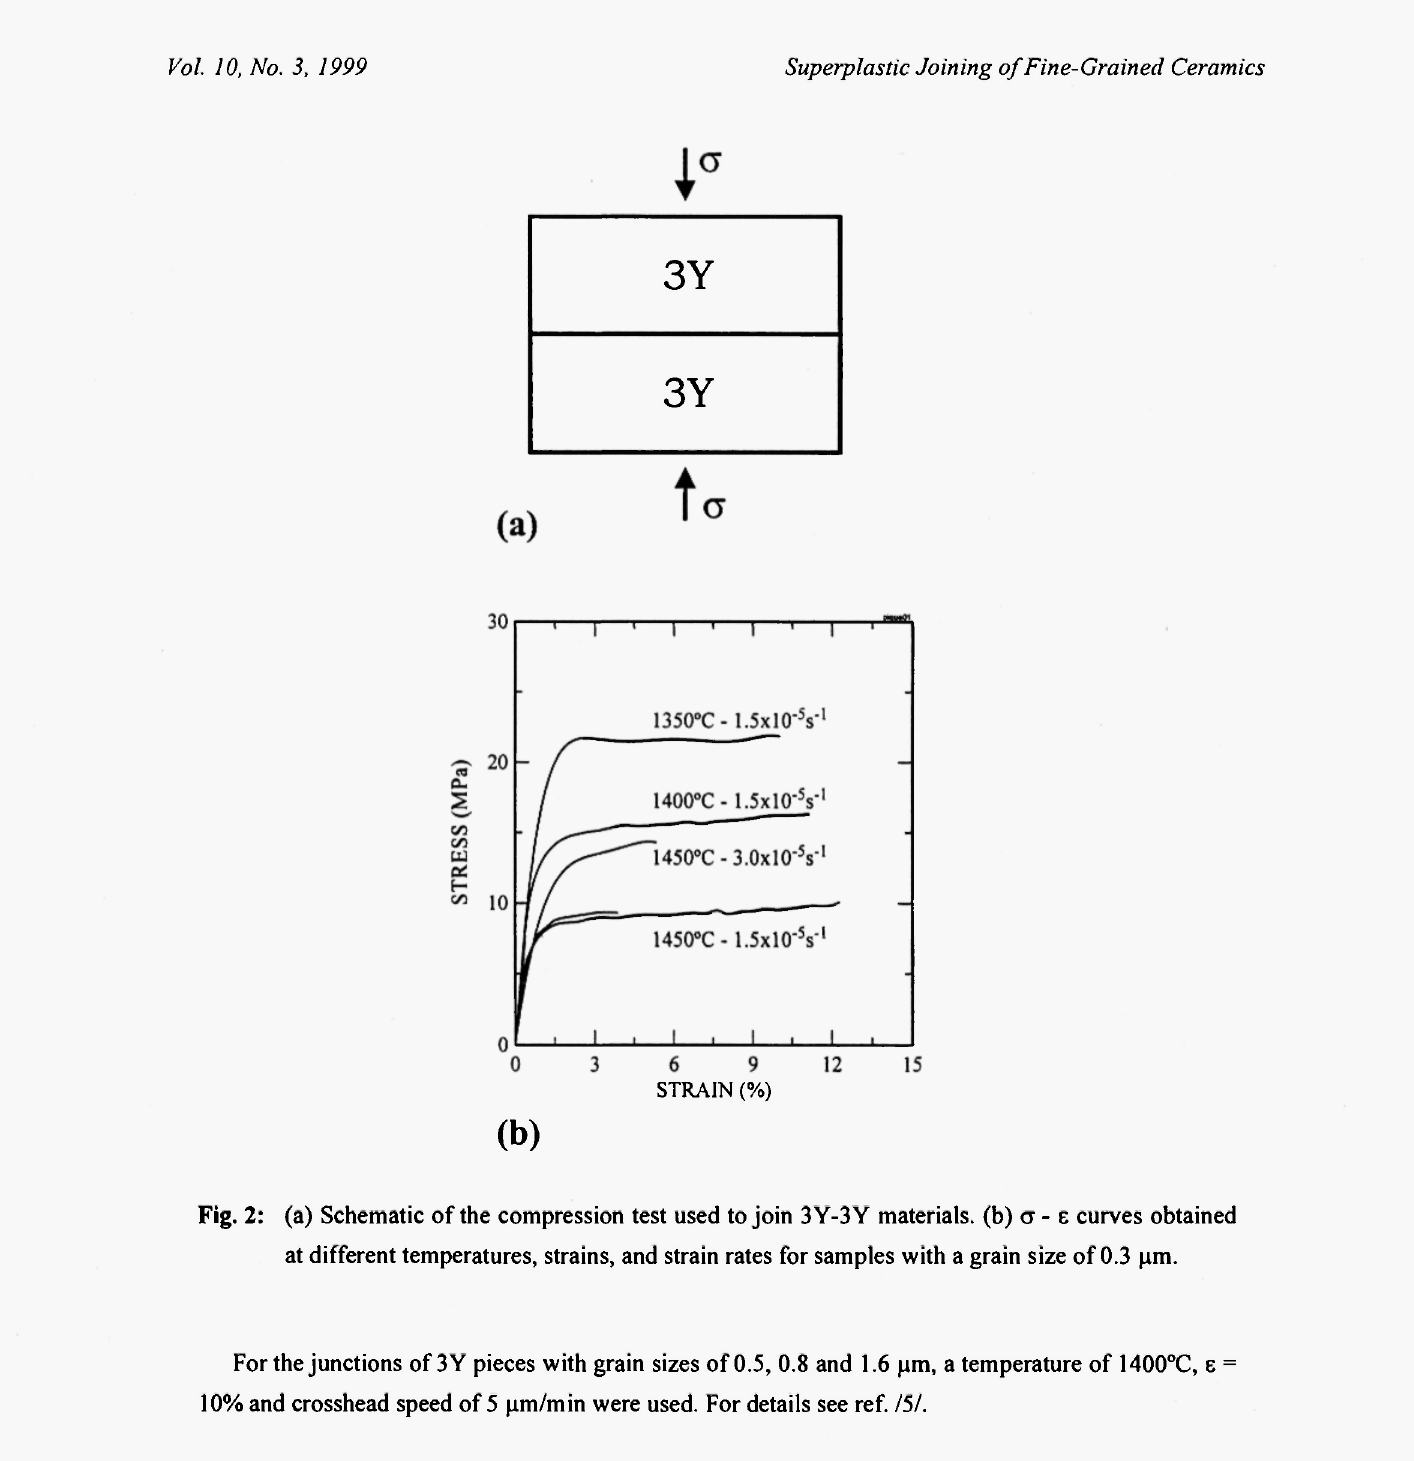
For the junctions of 3Y pieces with grain sizes of 0.5, 0.8 and 1.6 μπι, a temperature of 1400°C, ε = 10% and crosshead speed of 5 pm/min were used. For details see ref.